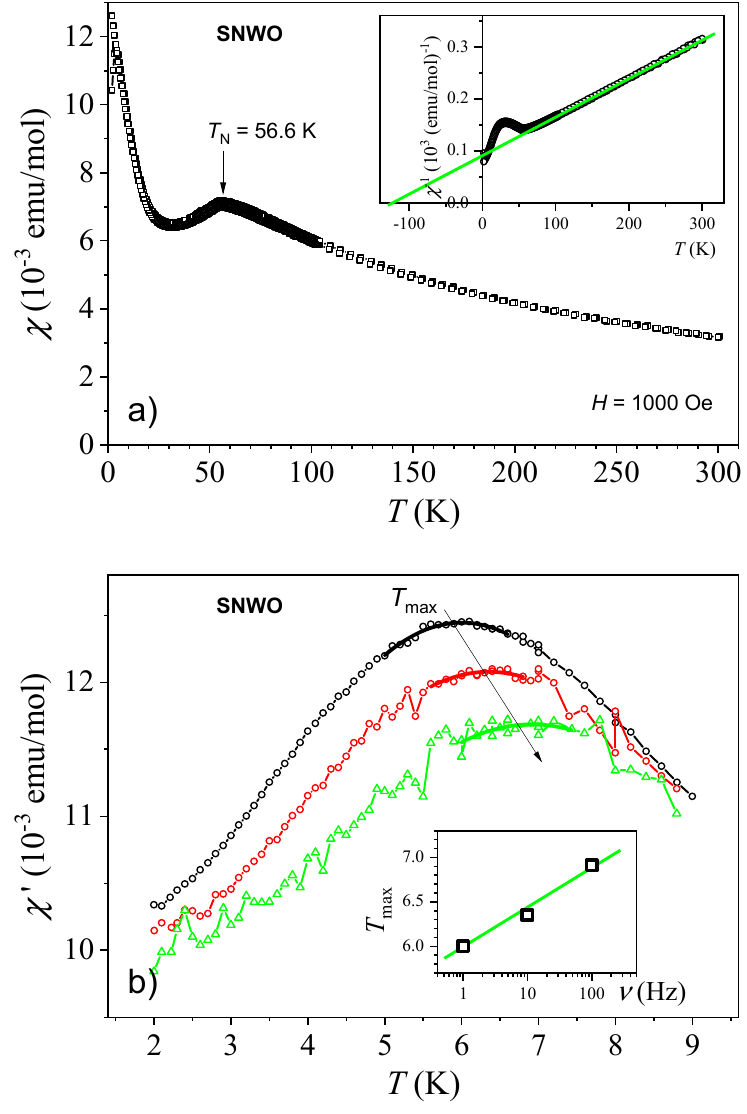
Figure 10. Temperature-dependent susceptibility and inverse susceptibility (inset) of SNWO ( a ). AC susceptibility (susceptibility in alternating magnetic field) around the low temperature peak ( b ) and shift of the maximum of AC susceptibility with frequency (inset in ( b )).